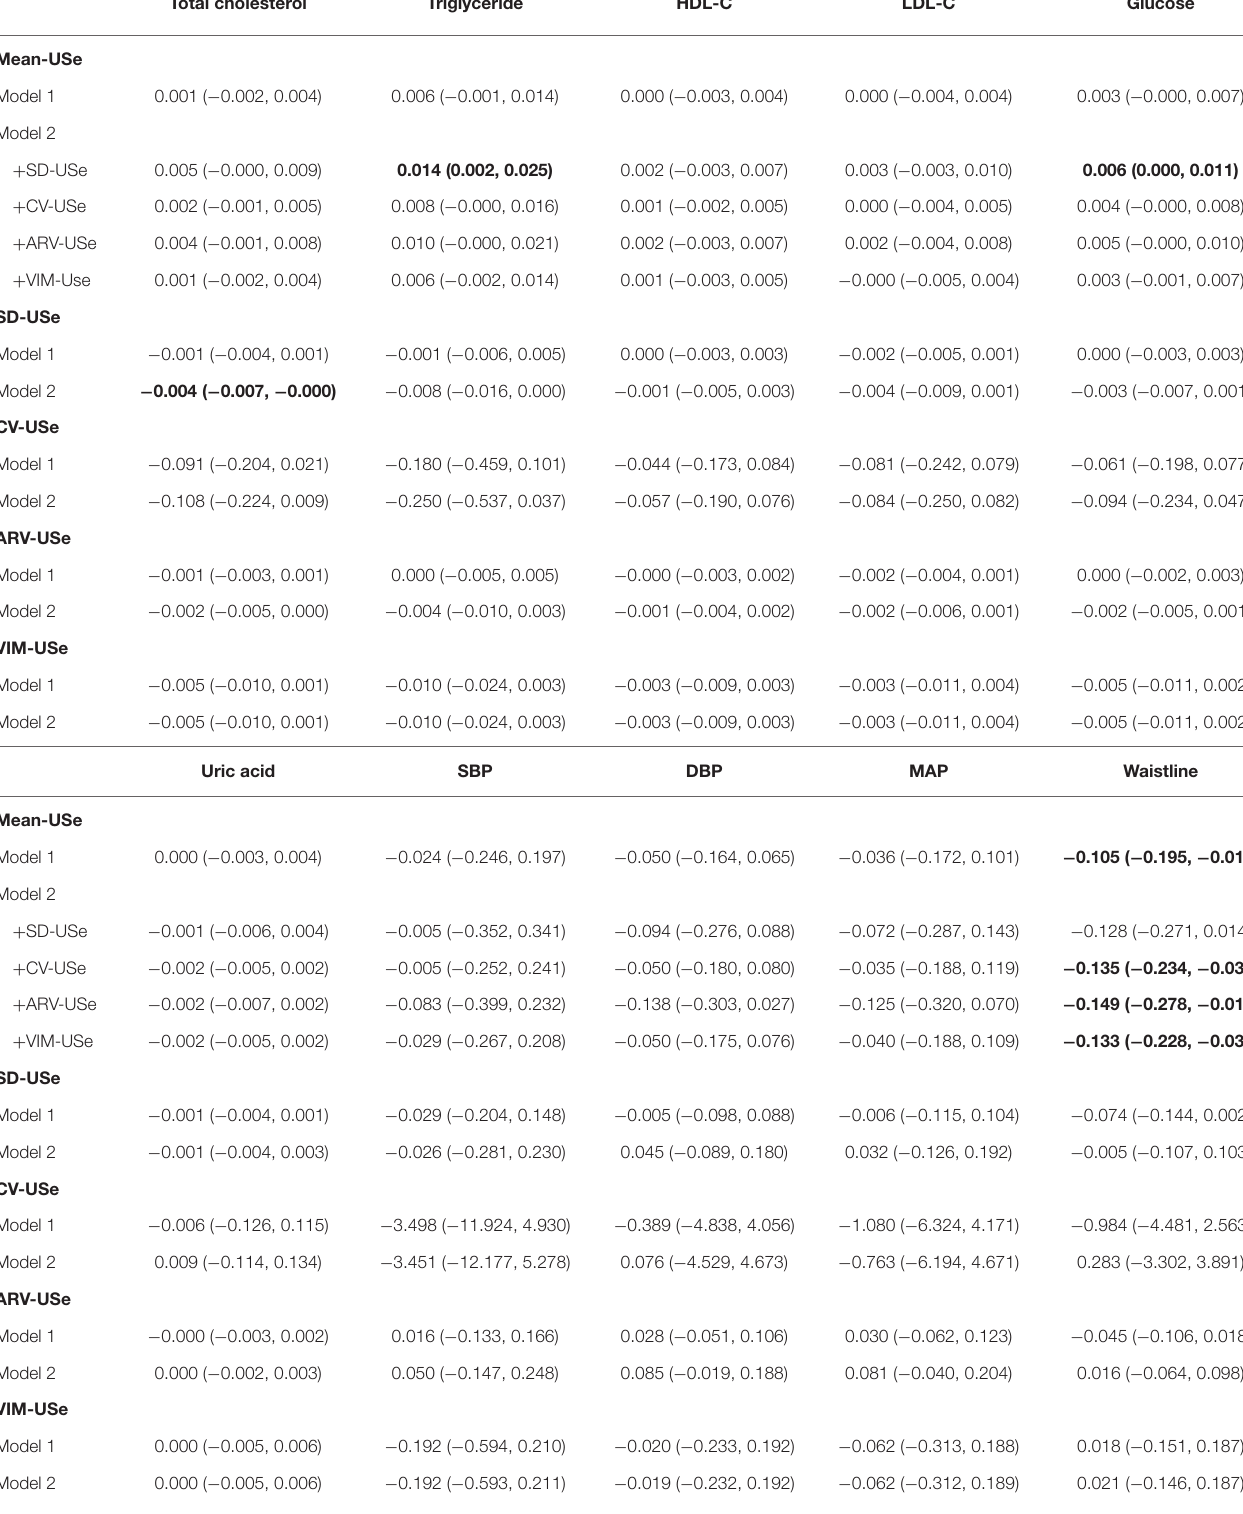
TABLE 6 | Changes and 95% confidence intervals of cardiometabolic risk factors associated with one-unit increments in VVV and IM of urinary